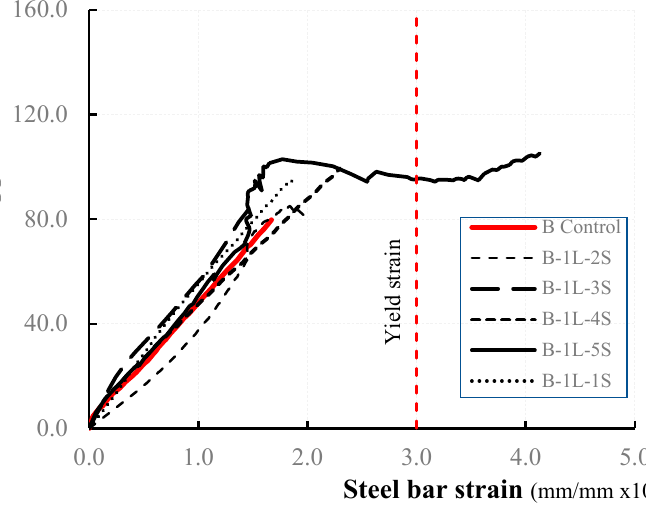
Figure 13. Load–steel bar strain curves for beams strengthened with one-layer SRG strips.